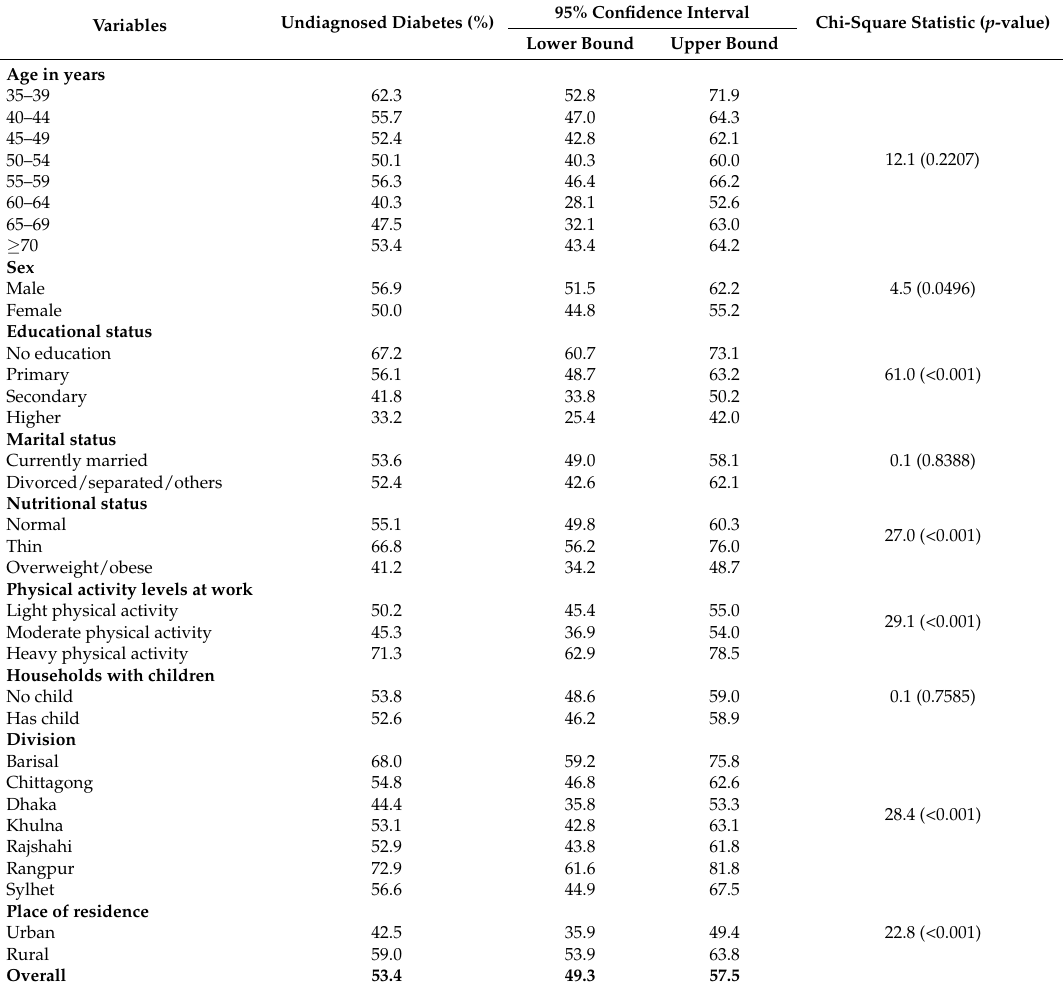
Table 2. Differentials in the prevalence of undiagnosed diabetes among adult diabetic patients across background